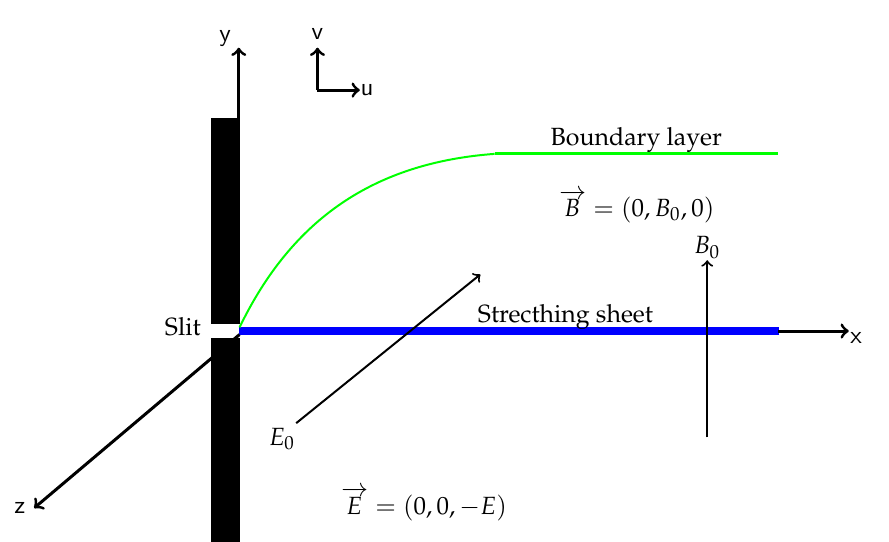
Figure 1. Flow configuration and coordinate